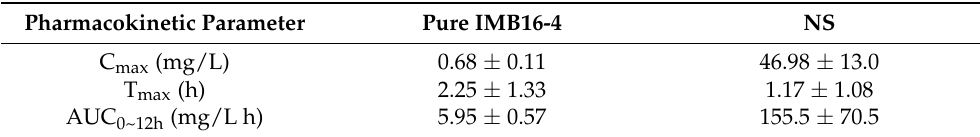
Figure 5. Plasma concentration–time profiles of pure IMB16-4 and NS. Results are expressed as the mean with the bar showing SD values of six rats. Table 3. Pharmacokinetic parameters of pure IMB16-4 and NS after oral administration, mean ± SD ( n = 6).